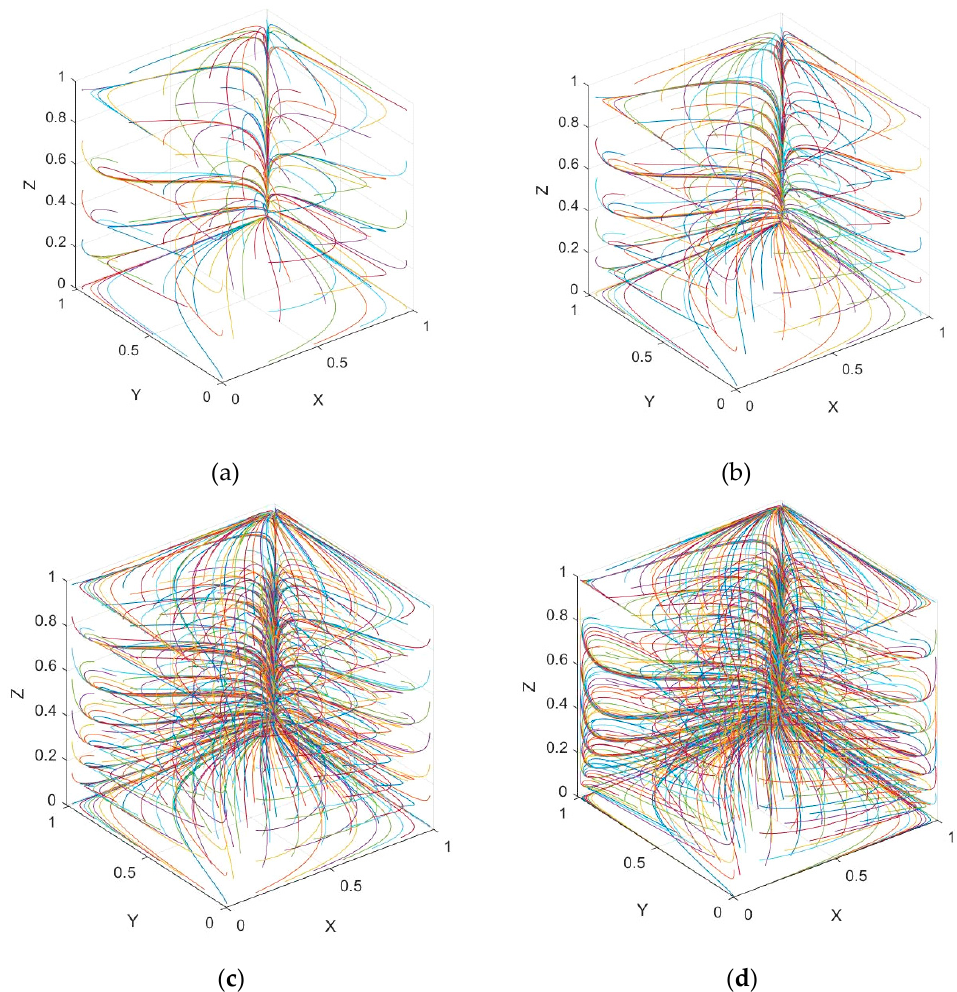
Figure 2. Dynamic simulation results of the initial assignment: ( a – d ) represents dynamic trajectories of strategy changes of (1,1,0) under 125, 216, 512, and 729 rounds dynamic simulations corresponding to 1 / 4, 1 / 5, 1 / 7, and 1 / 8 step size conditions, respectively.